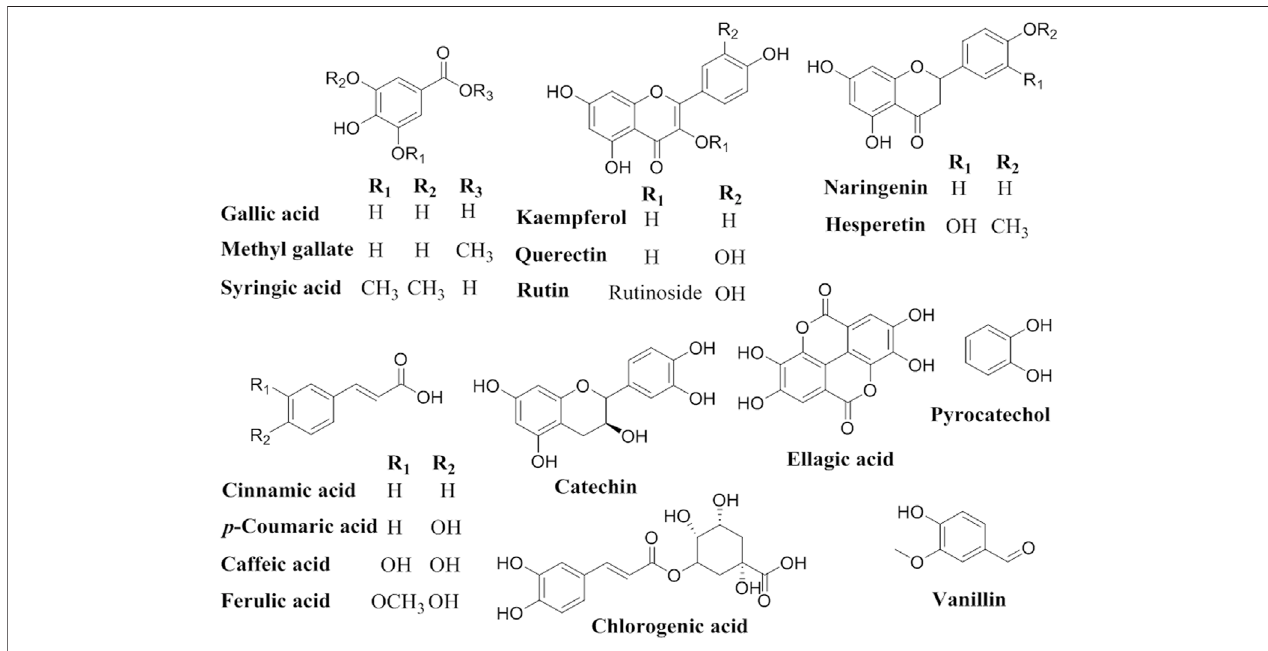
FIGURE 3 | Chemical structures of detected compounds in different extracts.